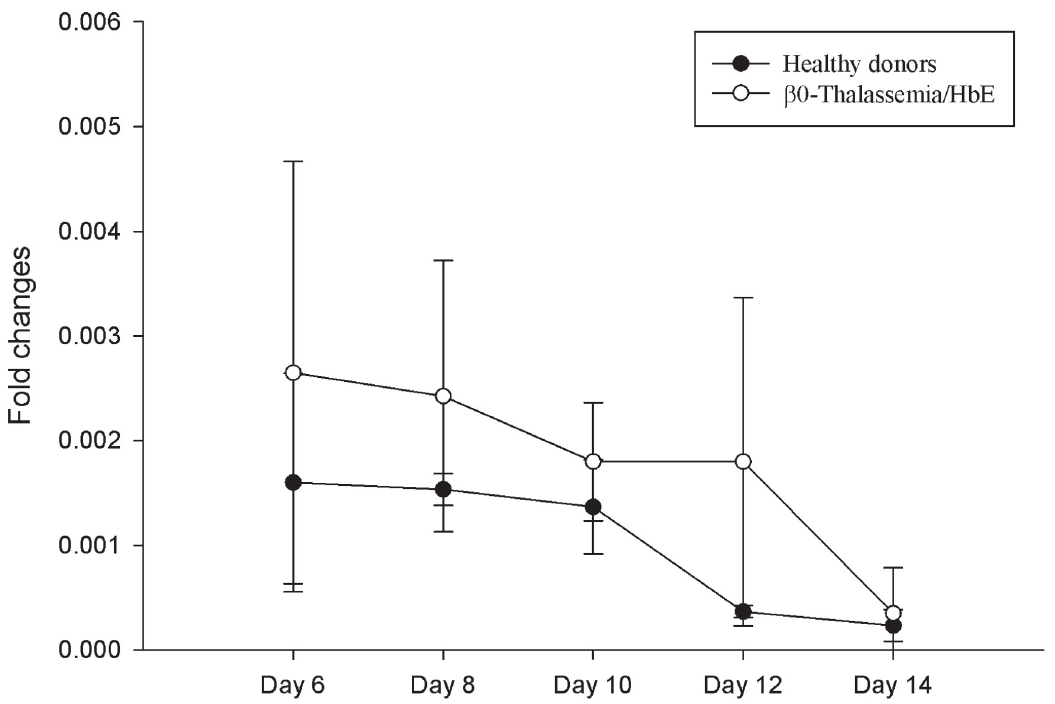
Fig 2. Relative expression of HBS1L during erythroid differentiation in healthy donors (N = 3) and β 0 -thalassemia/HbE patients (N = 4). Data is presented as mean ± SD.